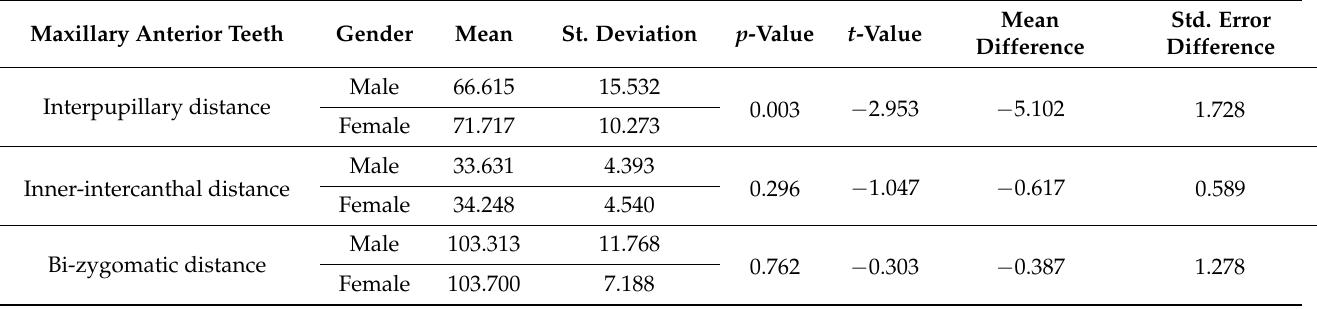
Table 7. Table 7. The comparison of mid-horizontal facial proportion in both sexes, independent t -test analysis (Male n = 112 Female n =